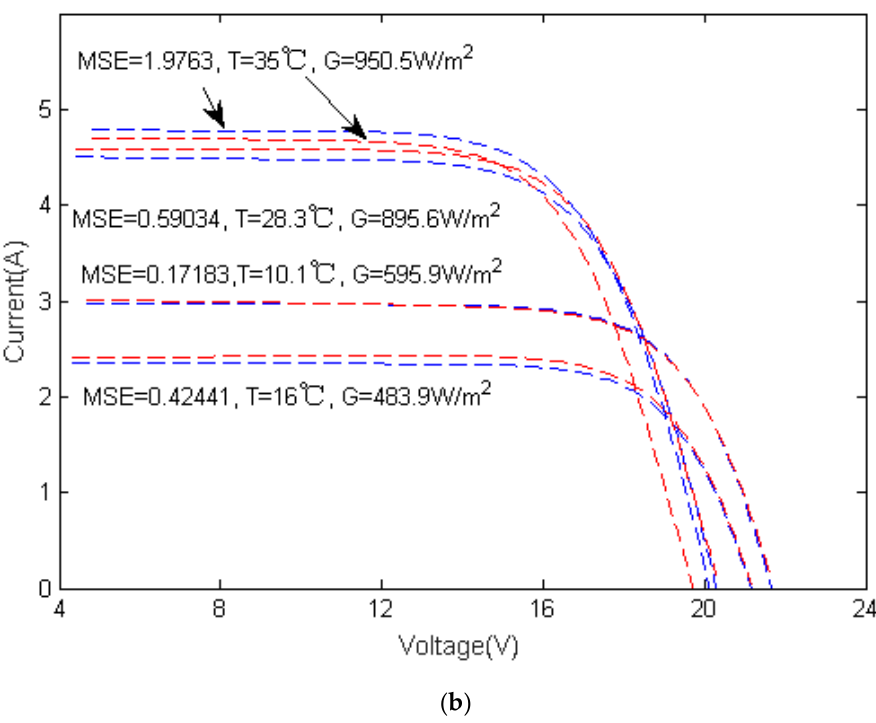
Figure 4. Prediction results when the temperature is 10.1 °C, 16 °C, 28.3 °C, and 35 °C, with the corresponding illumination intensity 595.9 W/m 2 , 483.9 W/m 2 , 895.6 W/m 2 , and 950.5 W/m 2 , respectively; ( a ) first prediction results; ( b ) second prediction results.